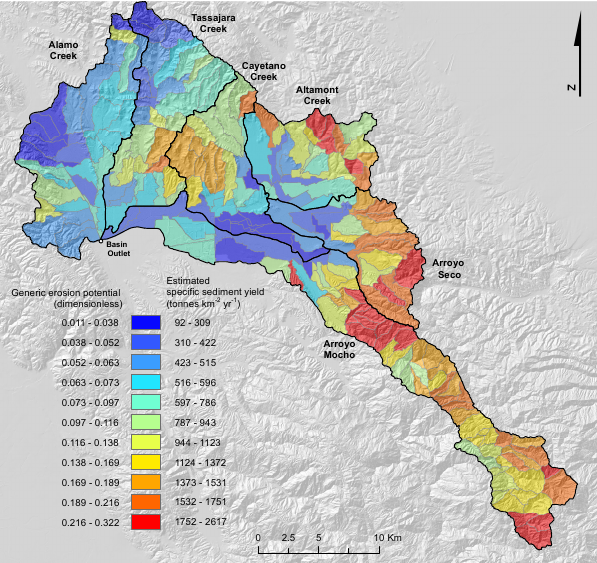
Figure 6. GEP and estimated specific sediment yields at the sub- watershed scale.